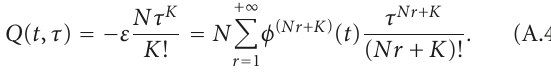
Figure 19: ROC curves for detection by GCD for decreasing